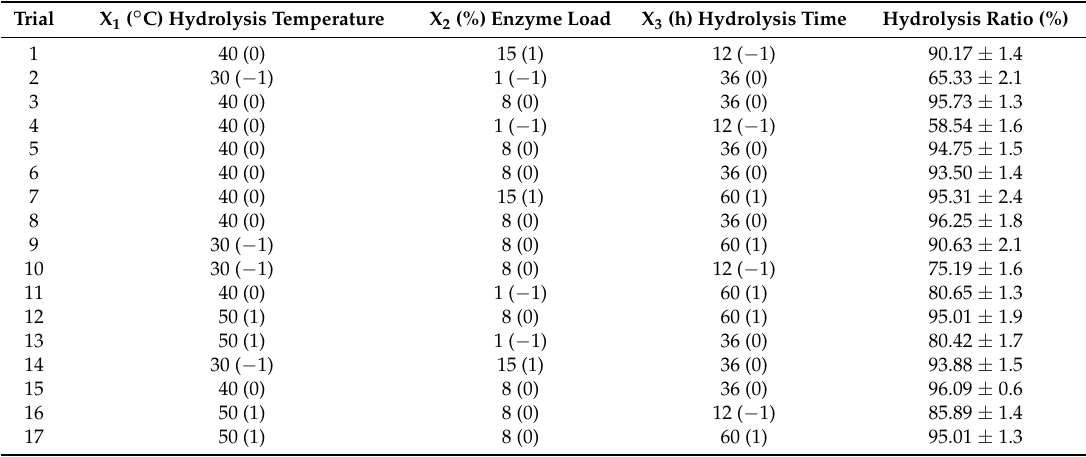
Table 1. Box–Behnken design and results of hydrolysis of CO as affected by hydrolysis time, hydrolysis temperature, and enzyme load with 0.031 mol CO in the presence of 22.04 mL water.